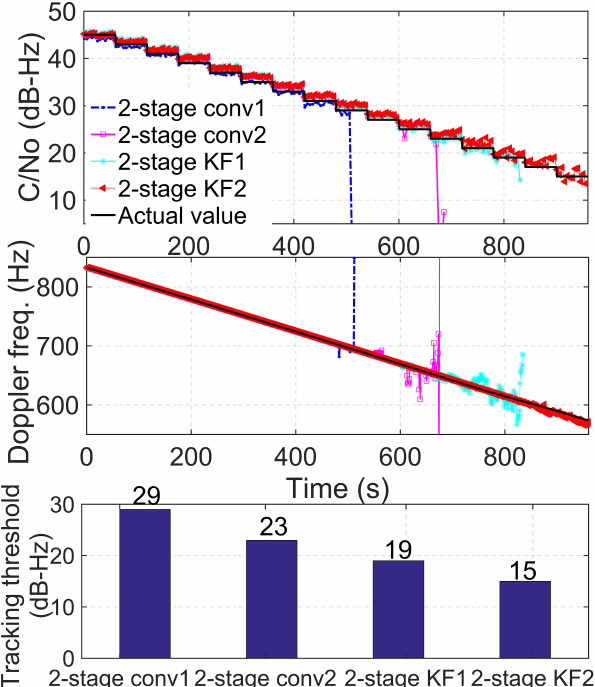
Figure 5. Tracking sensitivity, Doppler frequency, and tracking thresholds estimated by the four tracking algorithms for PRN 14 satellite signals under static weak signal environments. (PRN: pseudo-random